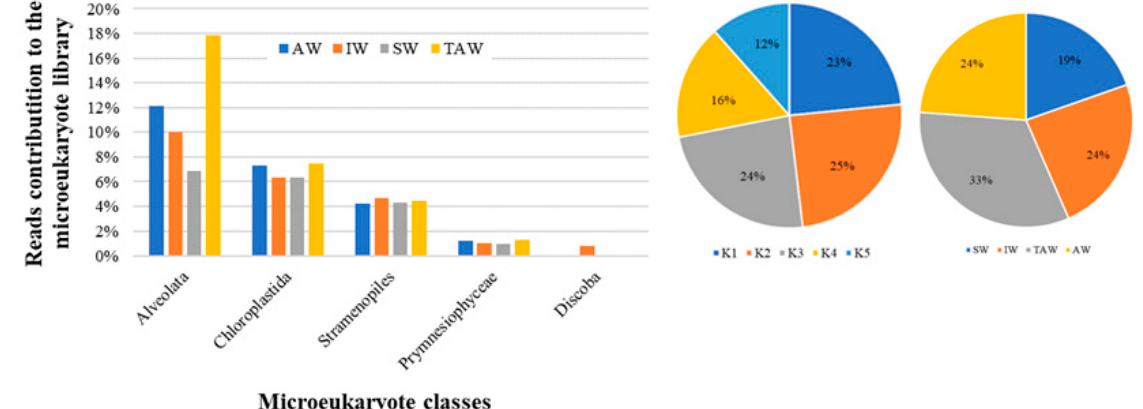
Figure 7. Proportion of microeukaryotic plankton in Kongsfjorden in 2015. Only classes with proportional contributions of no less than 1% to the DNA library were shown. SW = surface water; IW = intermediate mixed water; TAW = Transformed Atlantic Water.